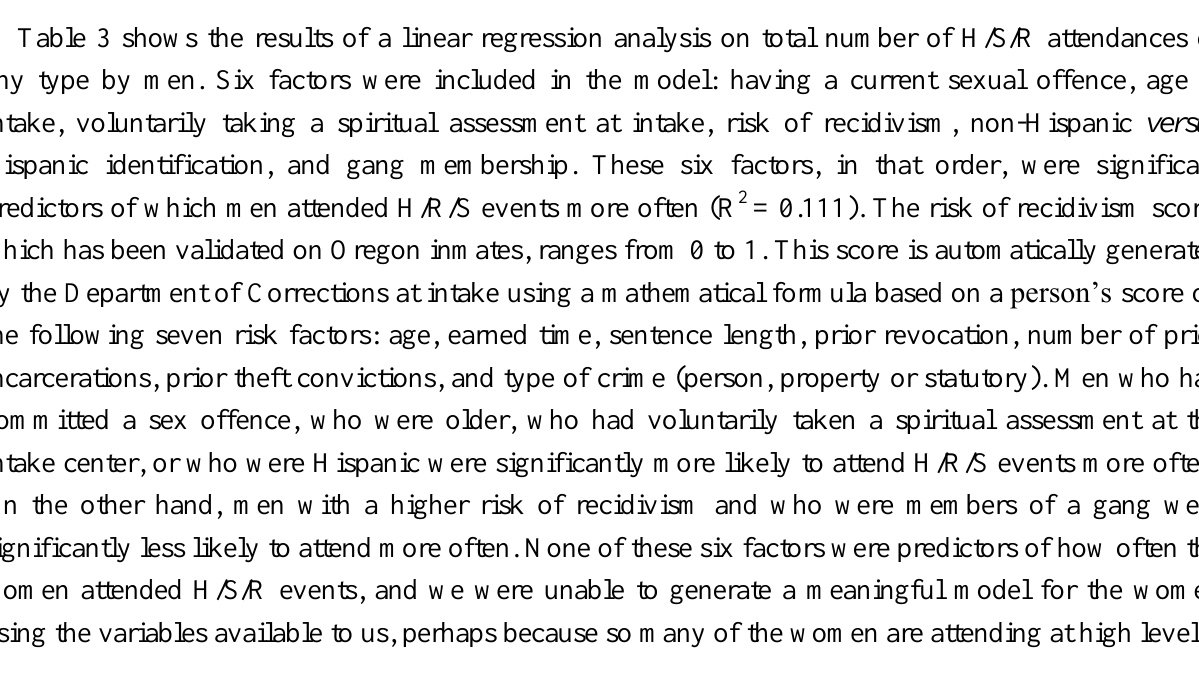
Table 3. Linear Regression Model Predicting Number of